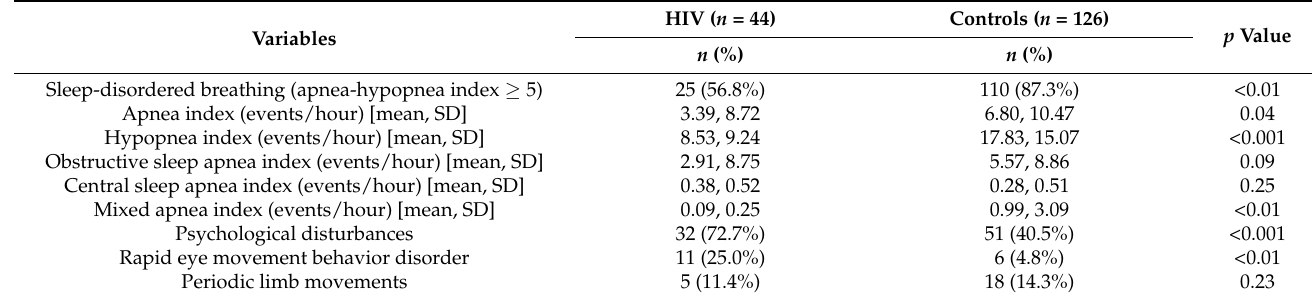
Table 3. Sleep disorders in HIV-infected persons and